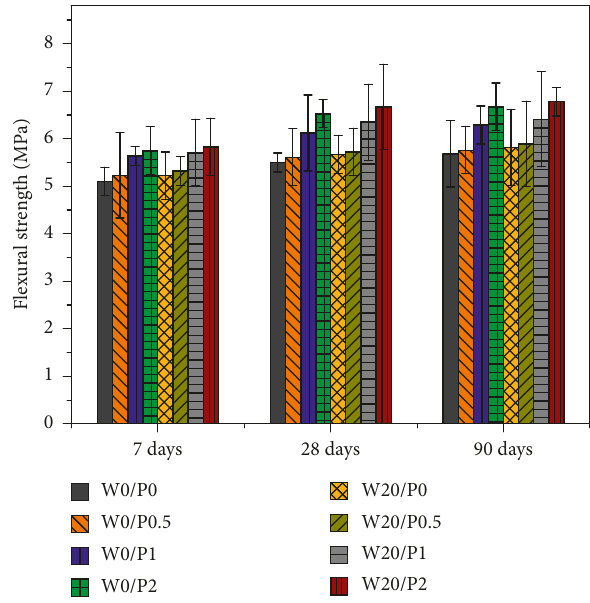
Figure 6: Flexure strength of the mortar specimens. Figure 5: Compressive strength of the mortar